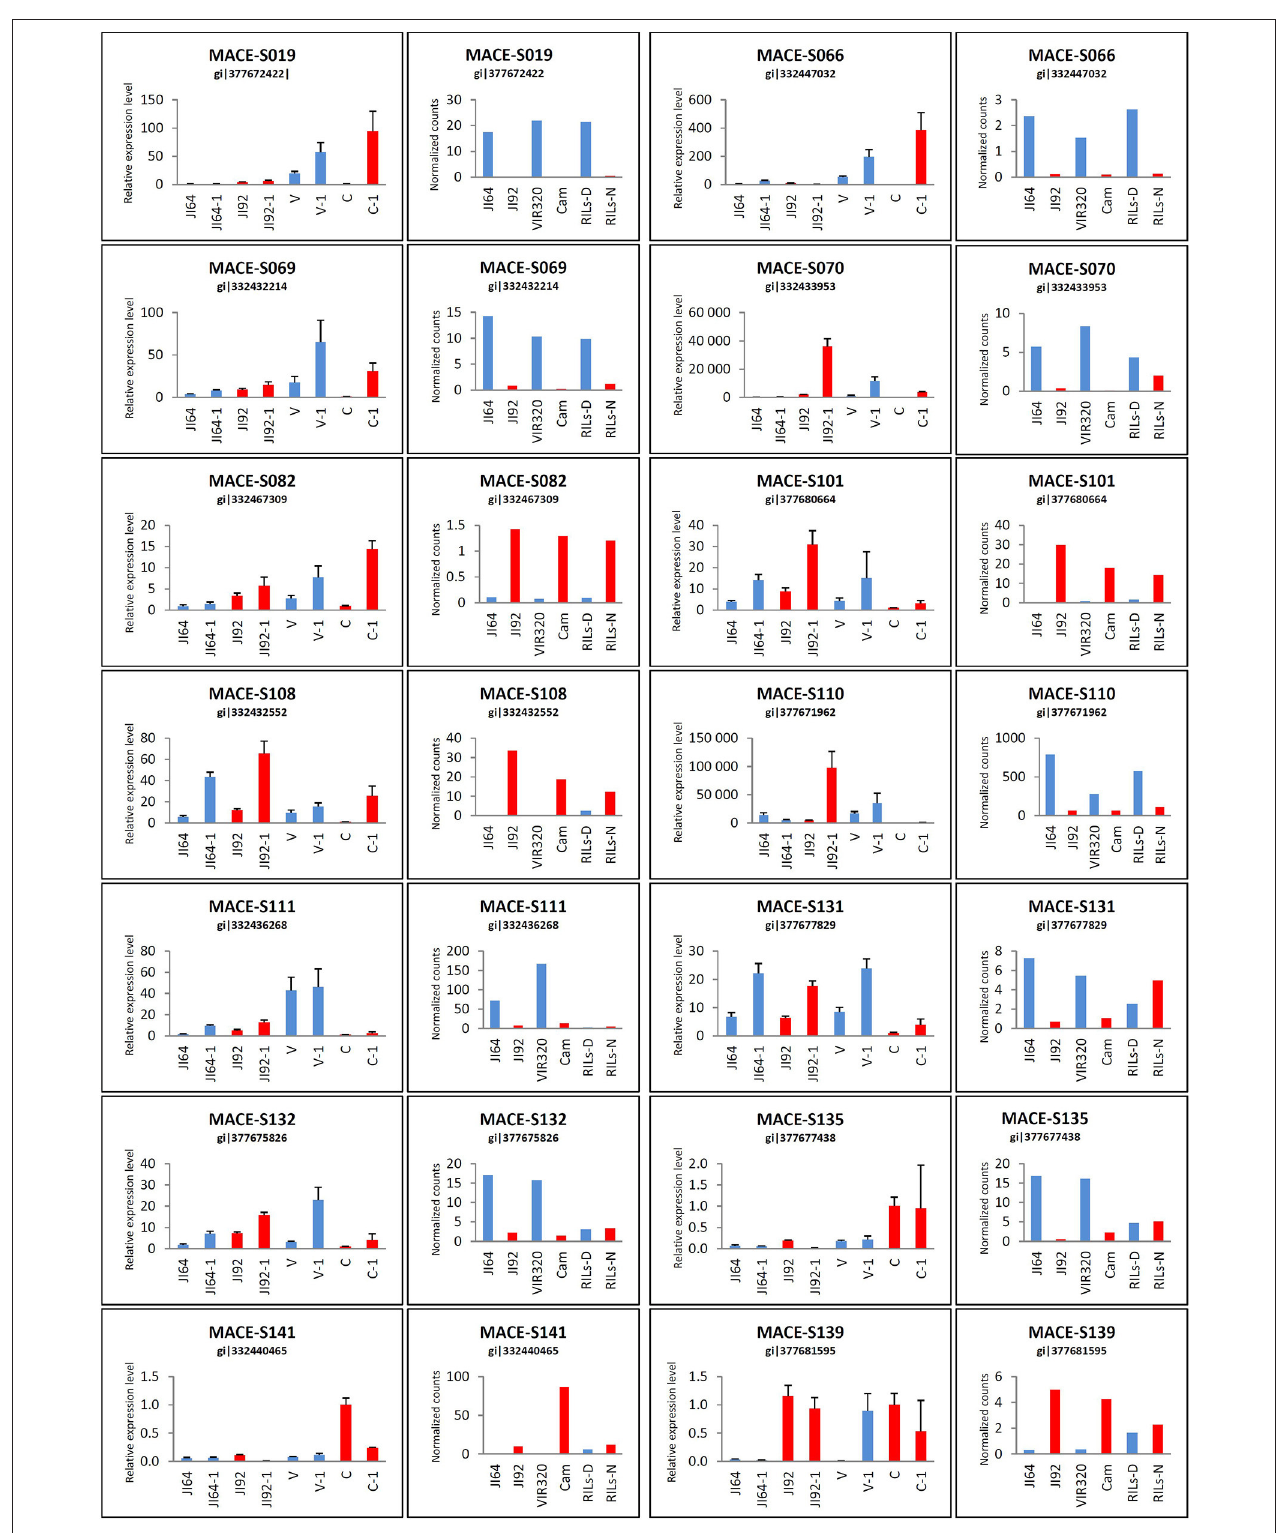
FIGURE 9 | qRT-PCR results of selected candidate genes in comparison with MACE analysis. qRT-PCR for four genotypes in two stages: JI64, JI92, V (VIR320), and C (Cameor)—younger stage; JI64-1, JI92-1, V-1, C-1—older stage and MACE for JI64, JI92, VIR320, Cam, RILs-D (dormant), and RILs-N